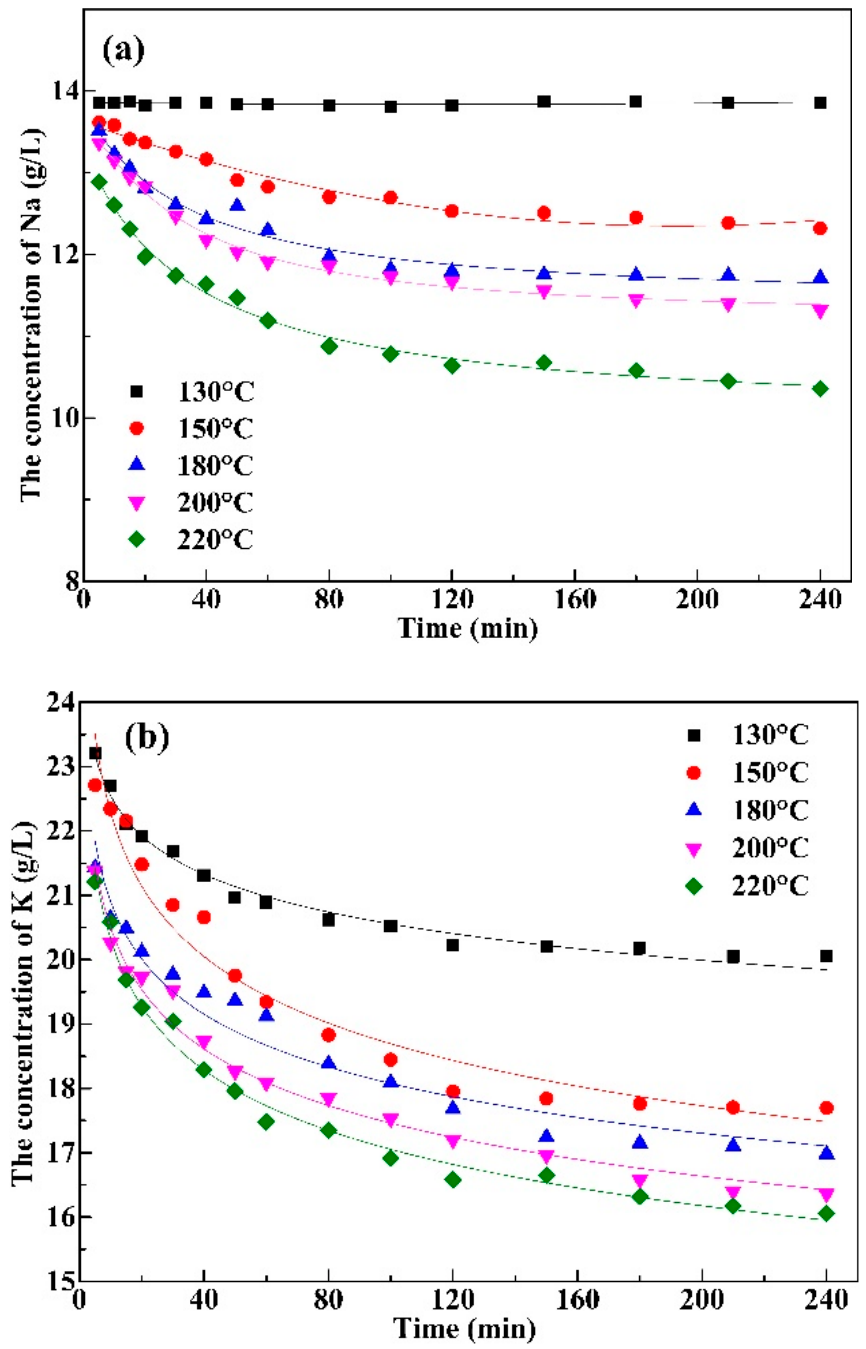
Figure 8. Variation in the concentration of Na + or K + with hydrothermal reaction at different tem- peratures: ( a ) Na 2 SO 4 ; ( b ) K 2 SO 4 . temperatures: ( a ) Na 2 SO 4 ; ( b ) K 2 SO 4